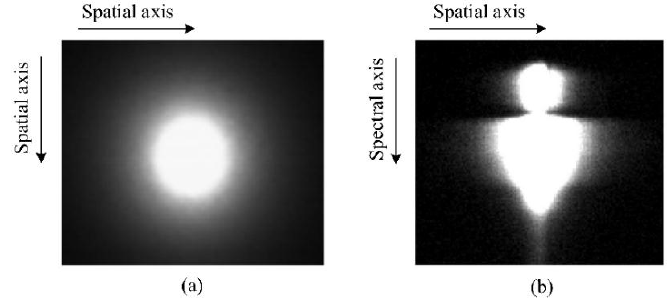
Figure 8. ( a ) Typical multispectral and ( b ) hyperspectral scattering images from apple fruit.